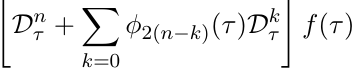
is bounded above. 2 c